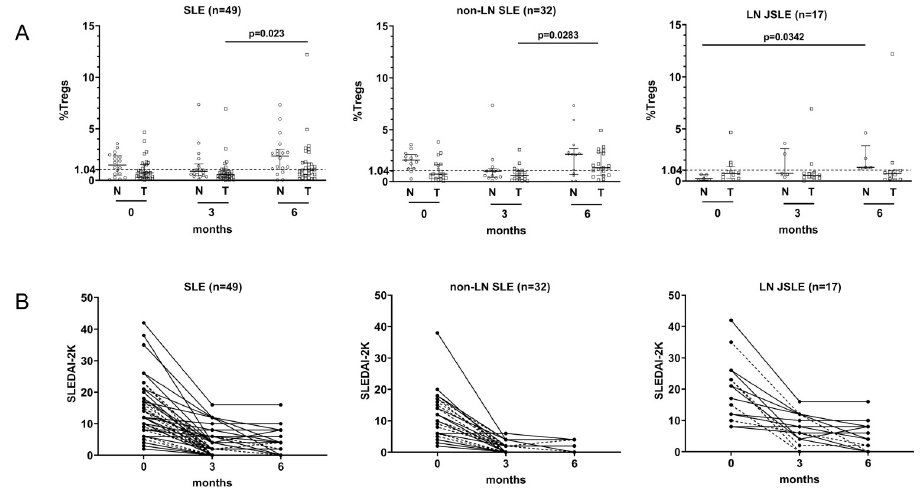
Fig 5. Regulatory T cells in JSLE patients, stratified into treatment-na ï ve and treated groups during 6-months follow-up. (A, B) Percentages of Tregs (A) and SLEDAI-2K (B) at 0, 3, and 6 months of follow-up in 49 JSLE patients. Horizontal lines represent medians and interquartile ranges. The horizontal dashed lines in (A) illustrate the medians in healthy controls. The dashed lines in (B) represent individual treatment-na ï ve patients, and solid lines in (B) represent individual treated patients. Total JSLE patients (treatment-na ï ve patients = 18, treated patients = 31), non- LN JSLE patients (treatment-na ï ve patients = 13, treated patients = 19), LN JSLE patients (treatment-na ï ve patients = 5, treated patients = 12). JSLE, juvenile-onset systemic lupus erythematosus; LN, lupus nephritis; Tregs, regulatory T cells; N, treatment-na ï ve patients; T, treated patients; SLEDAI-2K, systemic lupus erythematosus disease activity index